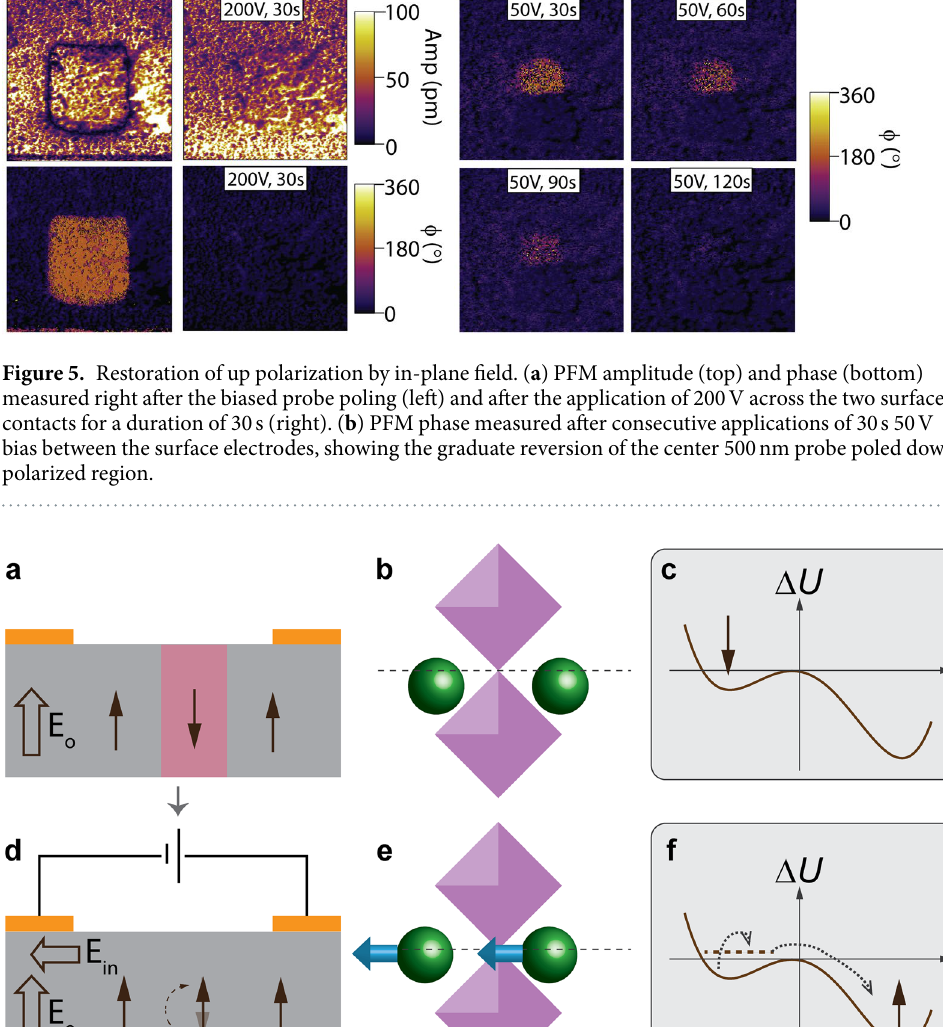
surface electrodes. After applying a 200 V relative bias across the two electrodes for 30 s, the center square region completely flipped back (Fig. 5a, right). Considering the 40 µ m gap, the 200 V bias can generate an in-plane field of × 5 10 6 V/m. The reversal of the out-of-plane polarization is slower at smaller field. At a relative electrode bias of 50 V, 120 s of in-plane field application time was needed to completely flip the down polarized domain (Fig. 5b). The observed results, however, are independent on the direction of in-plane field applied. Ferroelectric switching by biases applied between planar electrodes can be achieved when the polarization has an in-plane component 35–37 . Alternatively, cross-coupling between orthogonal electric field and ferroelectric polarization can also occur through, for example, a ferroelastic effect 38–41 . Though in that case, ferroelastic switch- ing usually produces field-orientation-dependent polarization rotations, instead of 180° flips. In order to under- stand the out-of-plane polarization reversal generated by an in-plane field, regardless of the bias polarity, the effects of E must be taken into account. As shown in Fig. 6b, Na ions are displaced downward from their 0 high-symmetry position after being poled by the positive probe bias. However, due to the shallow ferroelectric potential well and the effect of E , the activation barrier of this down polarization state is small (Fig. 6c). When an 0